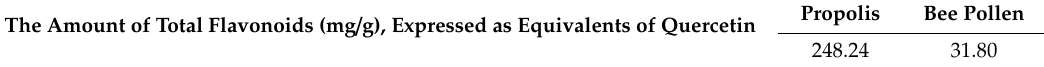
Table 2. The amount of total flavonoids (mg / g) in propolis and bee pollen, expressed as equivalents of